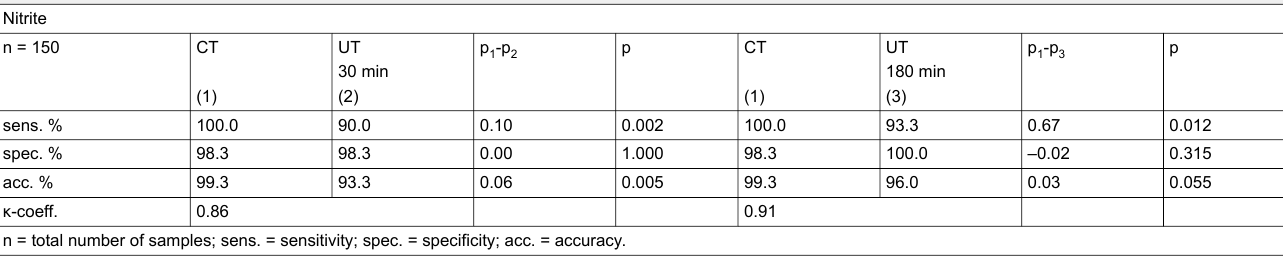
Table 5: Performance parameters for the detection of leucocytes by U-Test ® (UT) and Combur 10 Test ® (CT) determined in the in-vitro-study based on the result of the Multistix ® 10 SG as reference method and the two-sided significance (p) in differences between the two tests. Leucocytes n = 150